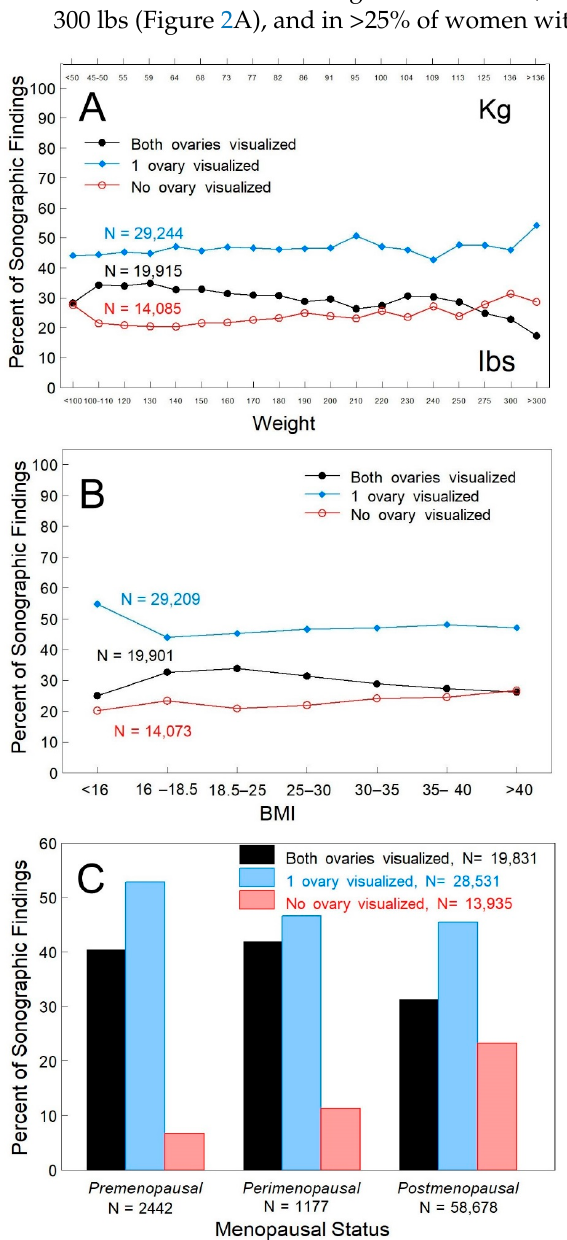
Figure 2. Ovarian visualization relative to weight, BMI and menopausal status when only one ovary is visualized on the first visit. Panel ( A ): Weight was reported in 63,244 TVS encounters. Panel ( B ): Weight and height were reported for the calculation of BMI in 63,183 TVS encounters. Panel ( C ): Menopausal status was self-reported at the time of the TVS exam in 62,297 TVS encounters. Sonographic findings visualizing both ovaries (black bar), one ovary (blue bar) or neither ovary (red bar). Differences in the number of TVS exams reflect unreported events (missing data) resulting in exclusion from analysis. Percentages were determined for each